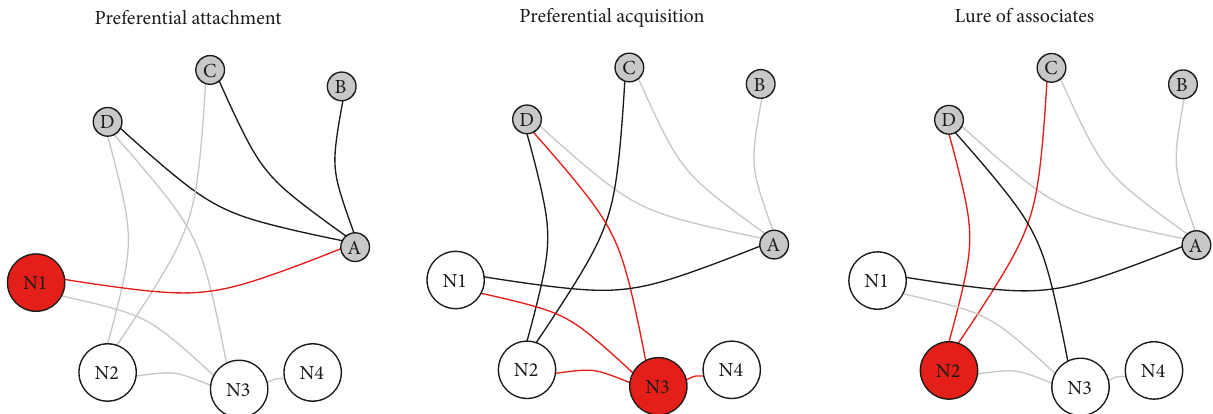
Figure 6: The three growth models of semantic networks. Note that the models make different predictions about which words are more likely to be acquired first despite having the same underlying network structure. Smaller, grey nodes indicate the words already known to the normative child and larger white nodes are words that are not yet learned. The red node is more likely to be acquired before the other nodes based on the model’s prediction. Adapted from Hills et al.